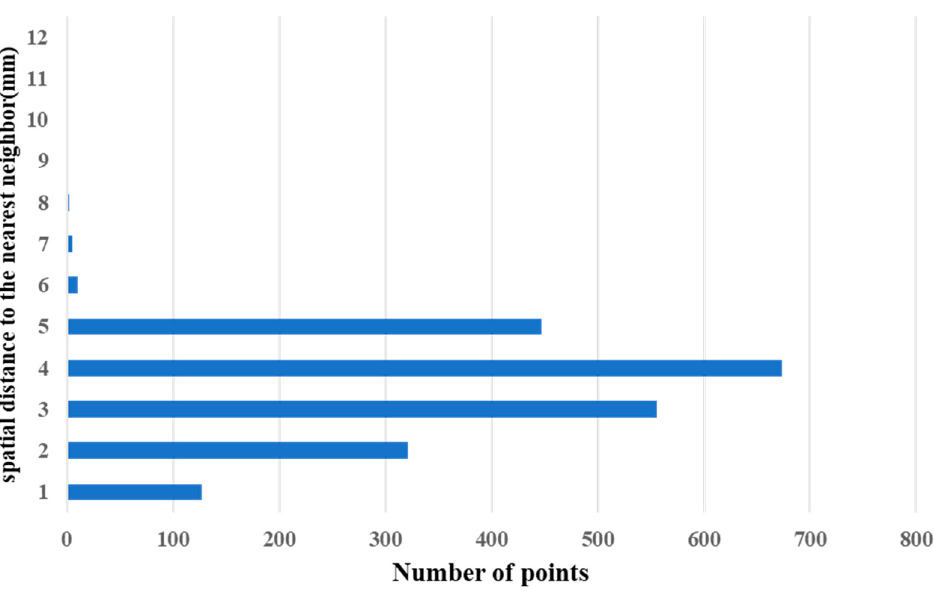
Figure 12. Histogram for estimating spatial Eps parameter.